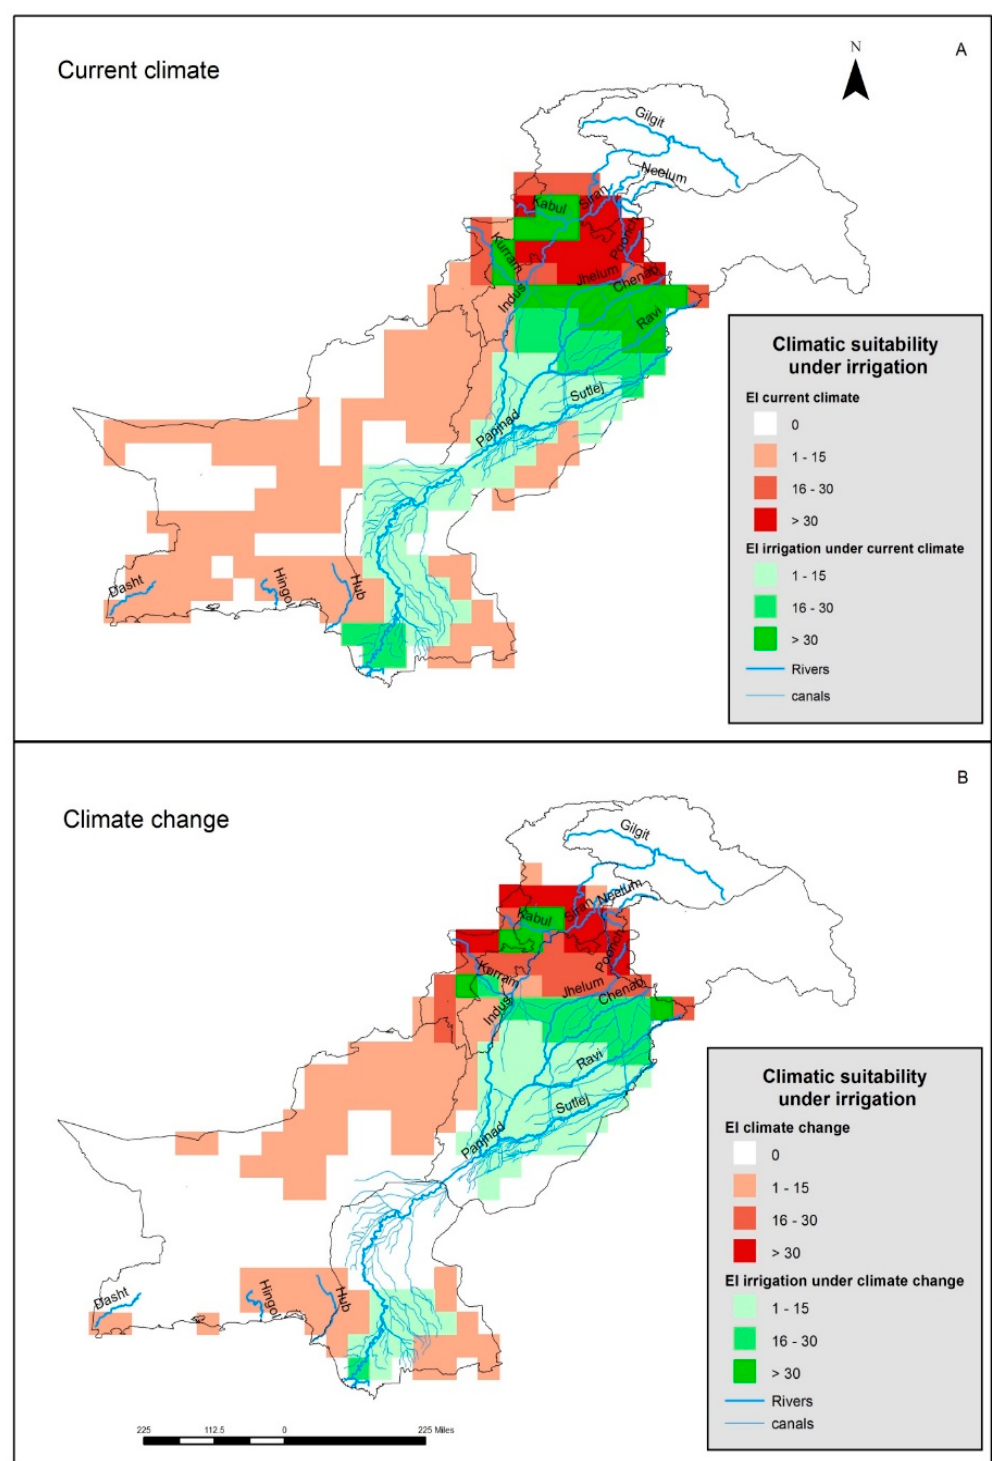
Figure 4. The climatic suitability for parthenium weed in Pakistan, when considering the extensive irrigation network, and ( A ) under the current climate or ( B ) under a climate change of +3 ◦ C, modeled using CLIMEX.